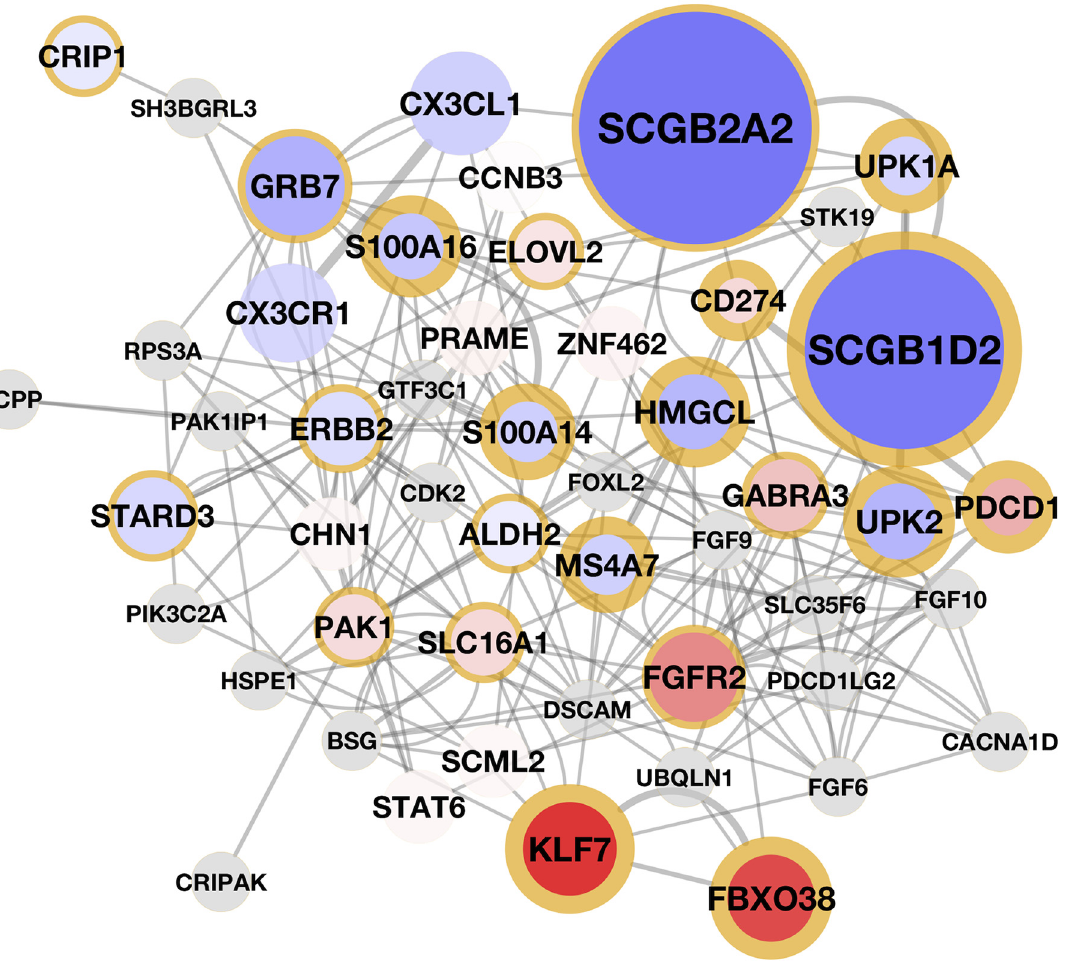
Fig 6. The two mechanisms of resistance to BIBW2992 placed in the context of a gene regulatory network. The network was constructed via GeneMANIA using the top 15 and bottom 15 genes of the model associated with the largest increase in GELnet performance over Elastic Nets. Genes captured by the model which is focused on the cell surface receptors are highlighted with a thin yellow border. Similarly, genes captured by the KLF7-centric model are highlighted with a thick yellow border. The size and the color intensity of a node designate the corresponding gene weight in the model. Red and blue nodes correspond to positive and negative weights, respectively. Gray nodes are “ linked genes ” included by GeneMANIA.